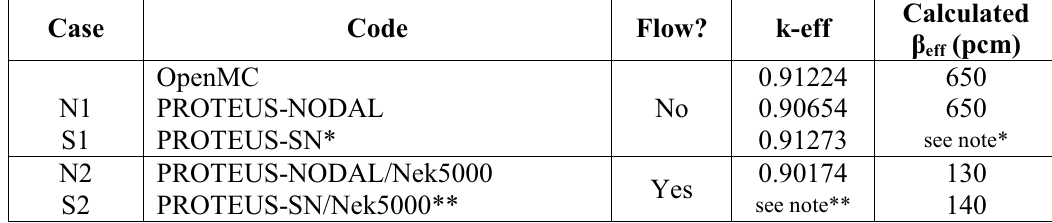
Table I. Eigenvalue and effective delayed neutron fraction comparisons